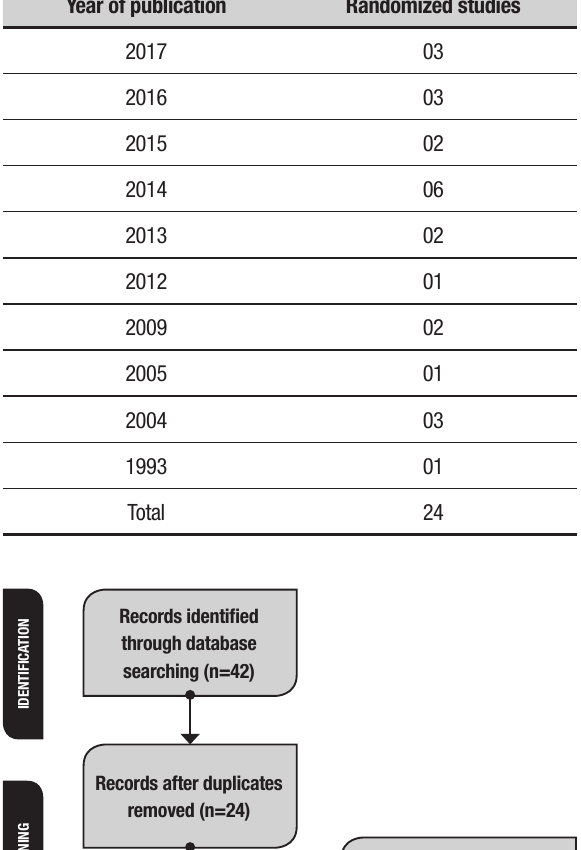
Table 1. Number of randomized trials by year of publication.